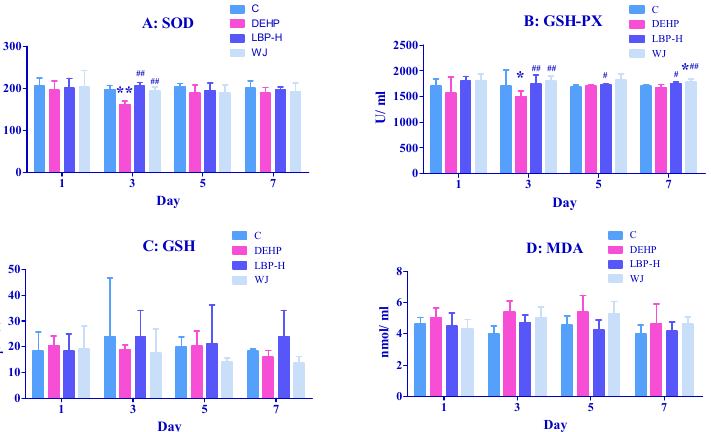
Figure 4. Effects of LBP and wolfberry juice (WJ) intervention on serum oxidative stress index in rats exposed to DEHP ( n = 8). After one day of DEHP feeding, LBP and WJ were used for continu- ous intervention, and the serum oxidative stress indexes (SOD, SGH-Px, GSH, MDA) were meas- ured by ELISA kit on the first, third, fifth, and seventh day of intervention. ( A ), ( B ), ( C ), and ( D ):